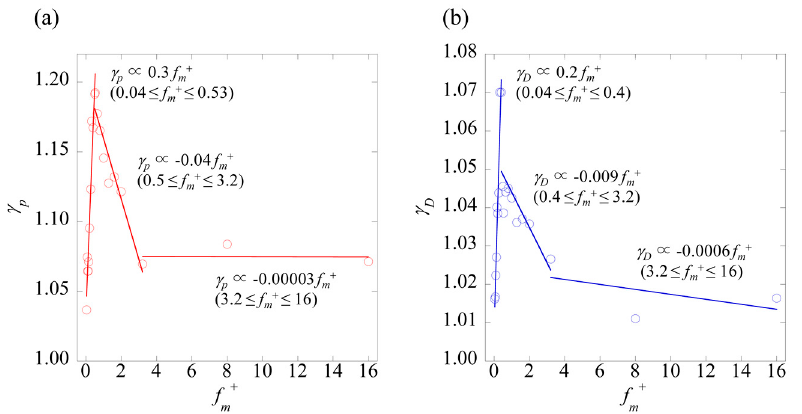
Figure 22. ( a ) γ p and ( b ) γ D as a function of f m + . Figure 23 visualizes the recirculation region by the contour line of u / U ∞ = 0.0 for the cases with